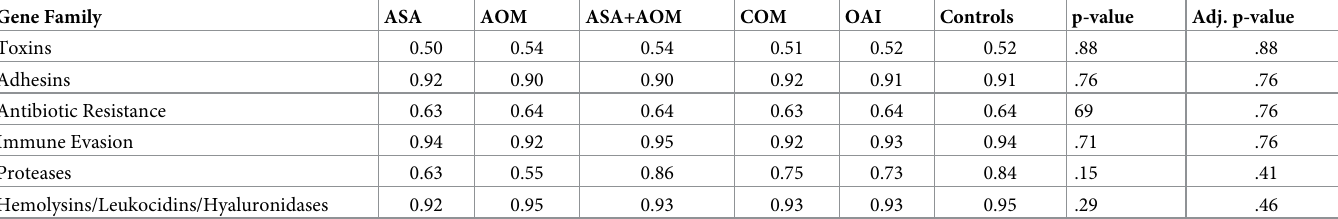
Table 3. Distribution of virulence gene families amongst Staphylococcus aureus isolates from children with osteoarticular infections compared with children with skin and soft tissue abscesses. Gene